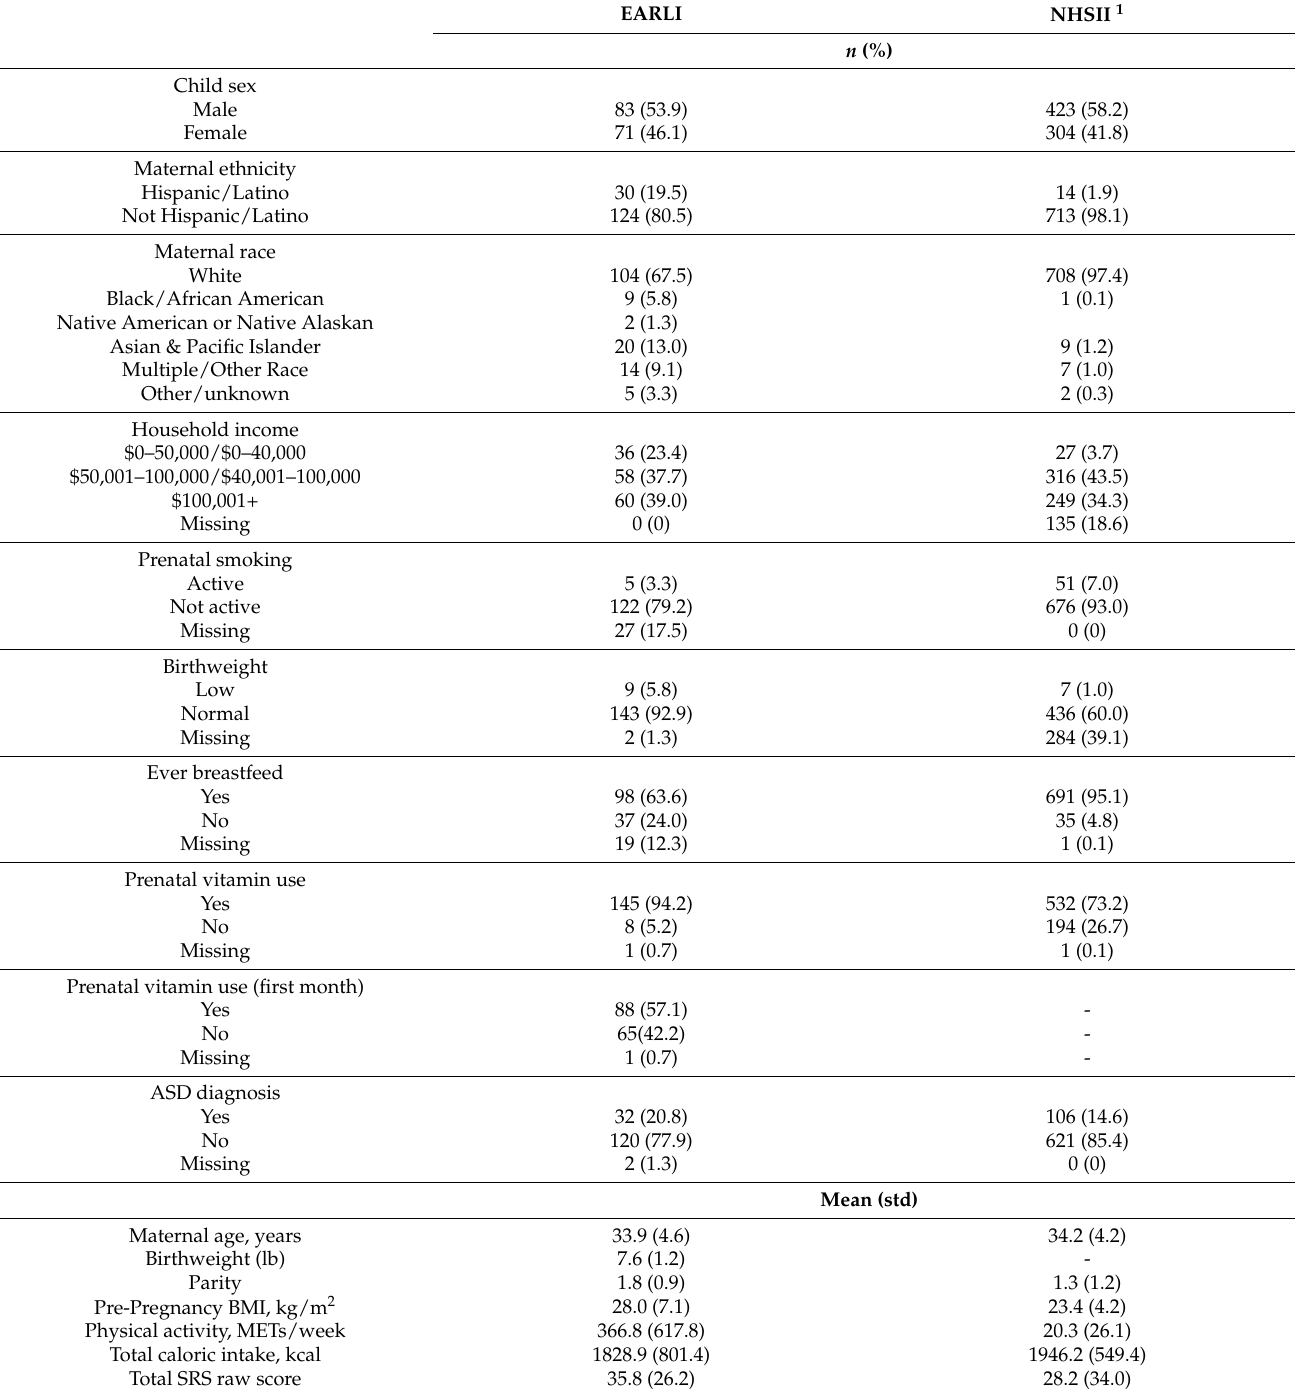
Table 1. Basic characteristics of the NHSII ( n = 727) and EARLI ( n = 154) study